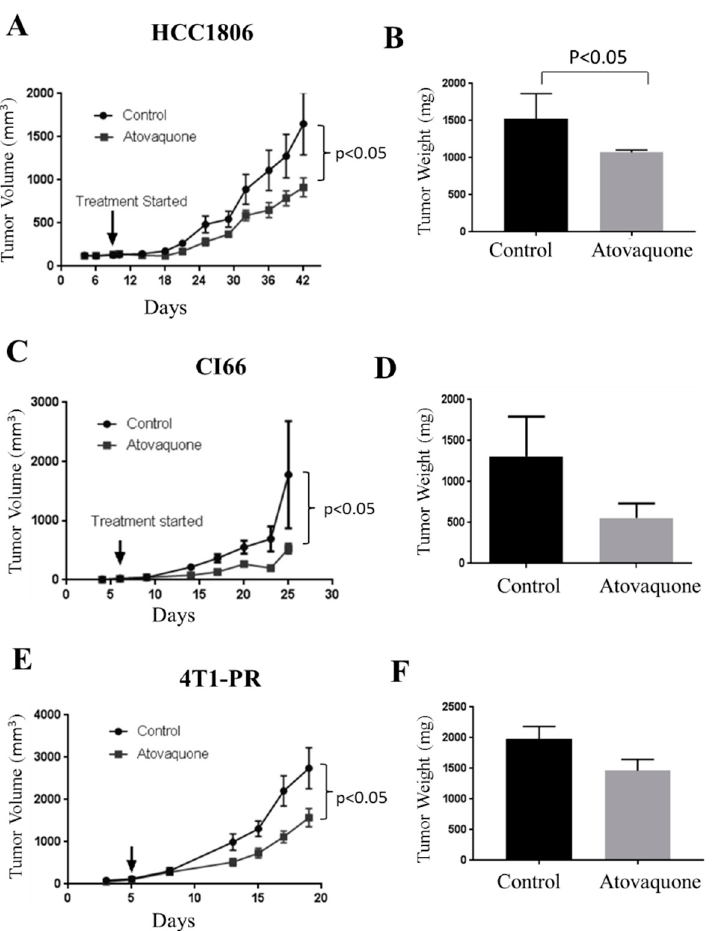
Figure 1. Atovaquone suppresses breast tumor growth. Human peripheral blood mononuclear cells (8 × 10 6 ) cells were injected intraperitoneally 7 days after HCC1806 tumor cells’ implantation in NCG/SCID mice; n = 5/group. ( A ) HCC1806 tumor growth curves. ( B ) Endpoint tumor weights. ( C ) Tumor growth curve of CI66 cells; n = 6/group. ( D ) Bar graph representing average tumor volume of control and atovaquone-treated mice at day 25; 4T1 paclitaxel-resistant cells were implanted in right and left flanks of female Balb/c mice, and treatment was 25 mg/kg atovaquone daily; n = 10/group. ( E ) Tumor growth curve. ( F ) Tumor weight from control and atovaquone-treated group at day 20. Values were plotted as mean ± SEM. Statistically significant at p < 0.05 when compared with control.